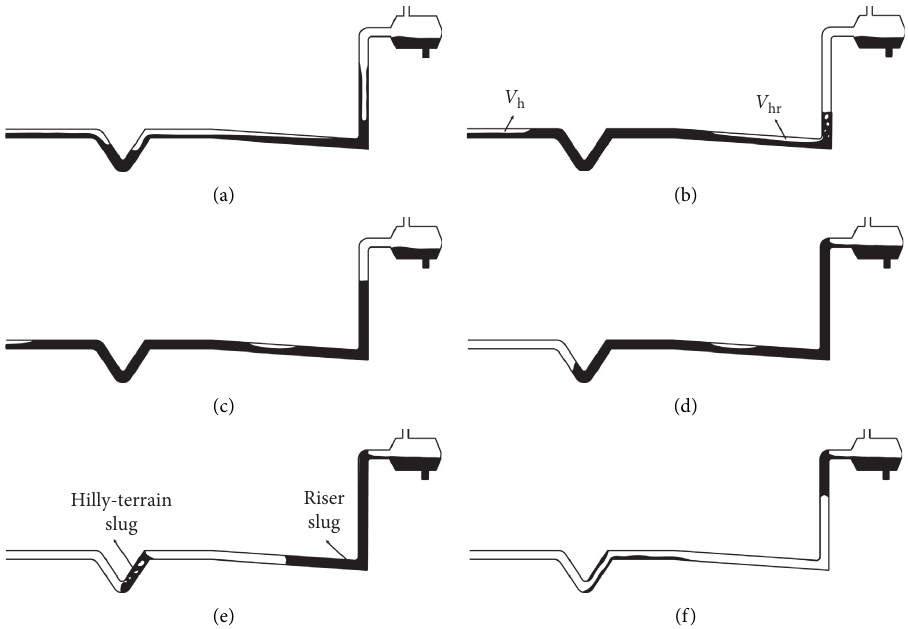
Figure 4: Schematic diagram of the gas-liquid flow cycle for severe slugging of type I. (a) Liquid fallback. (b) Gas discharging. (c) Slug growth. (d) Slug production (gas does not penetrate the slug). (e) Slug production (gas has penetrated the slug). (f) Gas-liquid blowout.